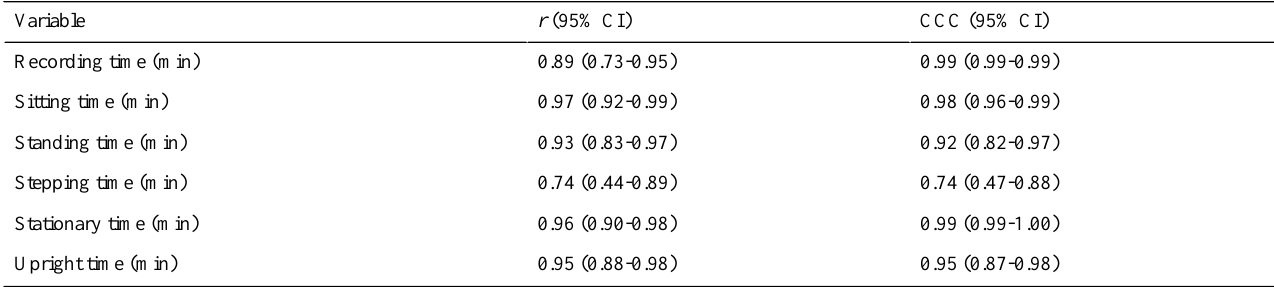
Table 2. Correlation coefficients ( r ), concordance correlation coefficients (CCC), and 95% CIs between the W@W-App+MetaWearC and the activPAL3M for minutes spent in different activity behaviors (N=20). All P